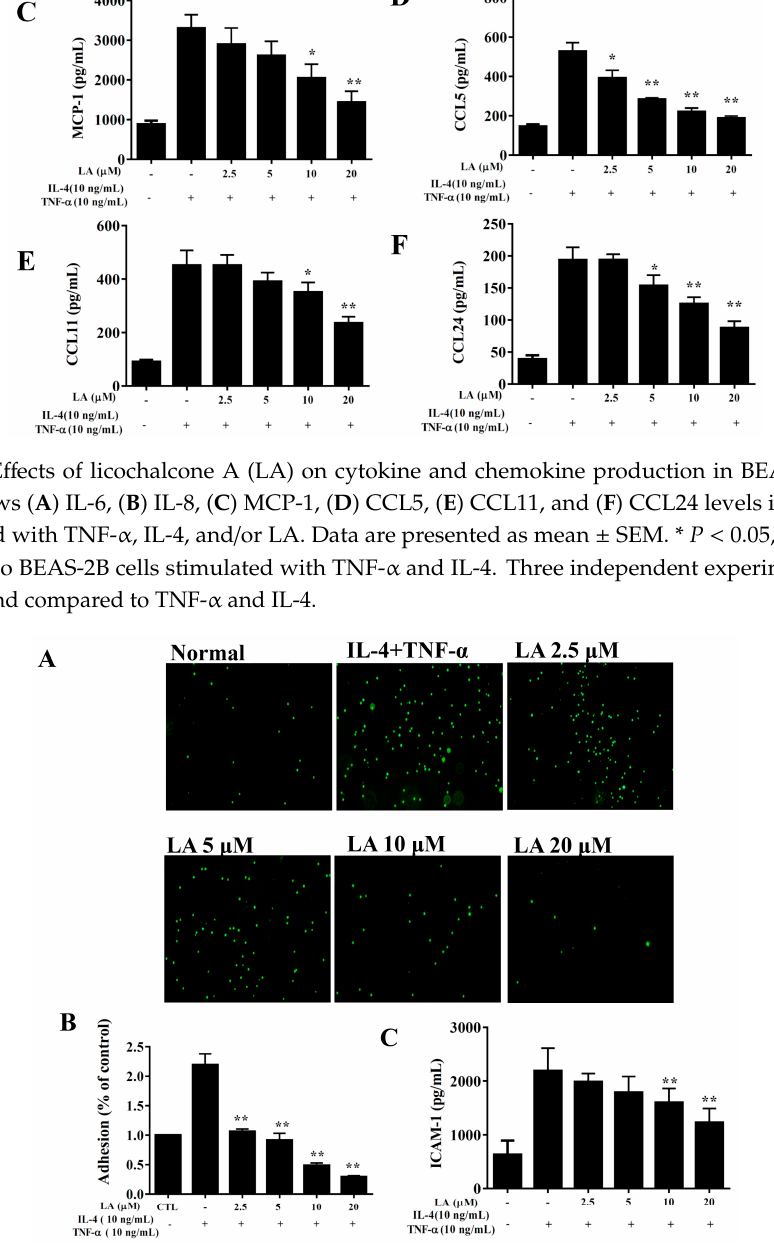
Figure 10. Licochalcone A (LA) inhibited THP ‐ 1 cell adherence to activated BEAS ‐ 2B cells. ( A ) Fluorescence microscopy images of THP ‐ 1 cells labeled with calcein ‐ AM and mixed with normal (N) and TNF ‐α /IL ‐ 4 ‐ activated BEAS ‐ 2B cells in the absence or presence of LA. ( B ) Fluorescence intensity of monocytic cell adhesion to BEAS ‐ 2B cells. ( C ) LA decreased the levels of ICAM ‐ 1 in BEAS ‐ 2B cells activated with TNF ‐α /IL ‐ 4. Three independent experiments were analyzed, and data were presented as mean ± SEM. * P < 0.05, ** P < 0.01 compared to BEAS ‐ 2B cells stimulated with TNF ‐α and IL ‐ 4.